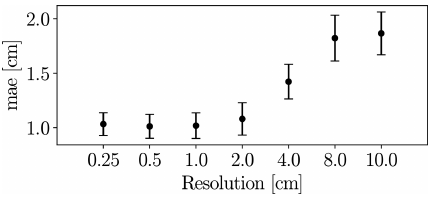
Figure 21. Performance of GRAINet d m regression with different image resolutions (trained with MSE